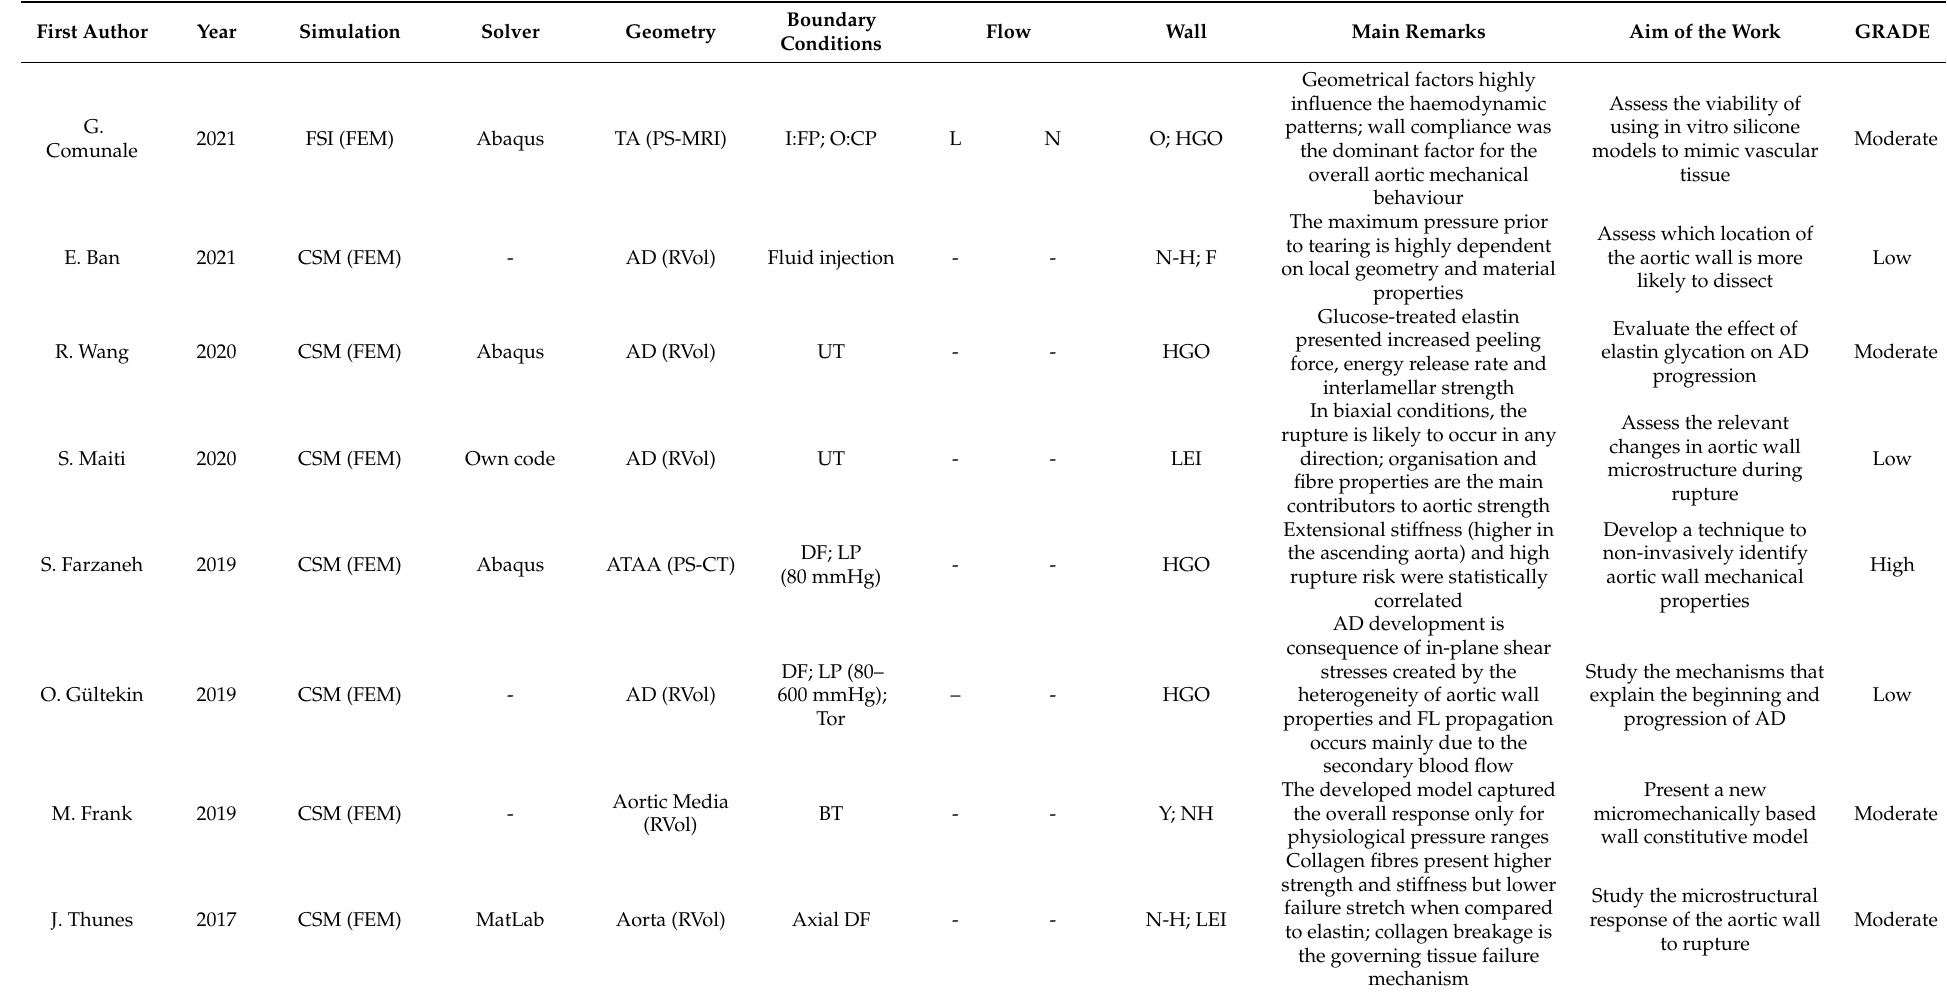
Table 3. Numerical models applied to study aortic wall microstructure ( n = 14